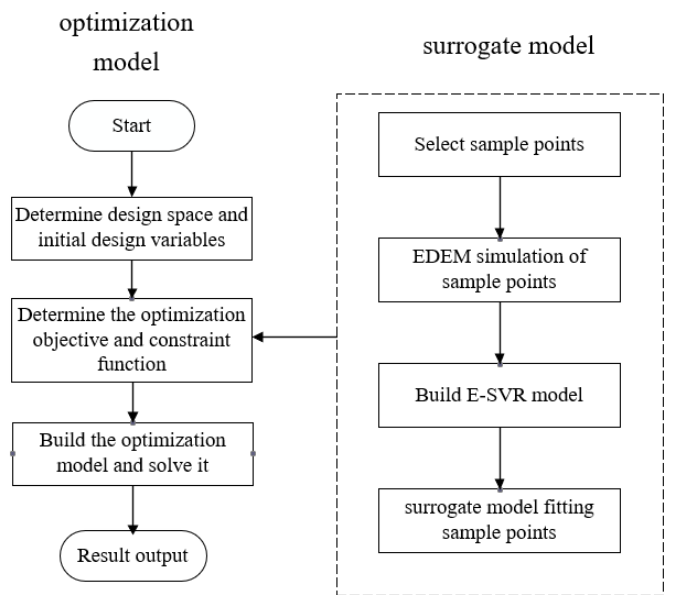
Figure 4. Design optimization of chute structure.